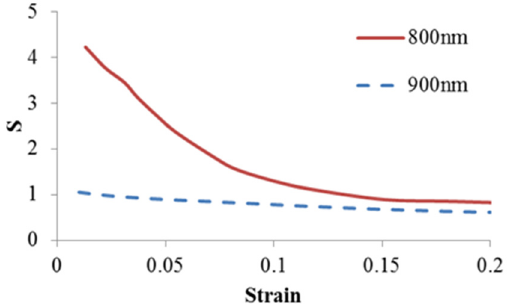
Figure 5. The impact of crosslink threshold on non-affine